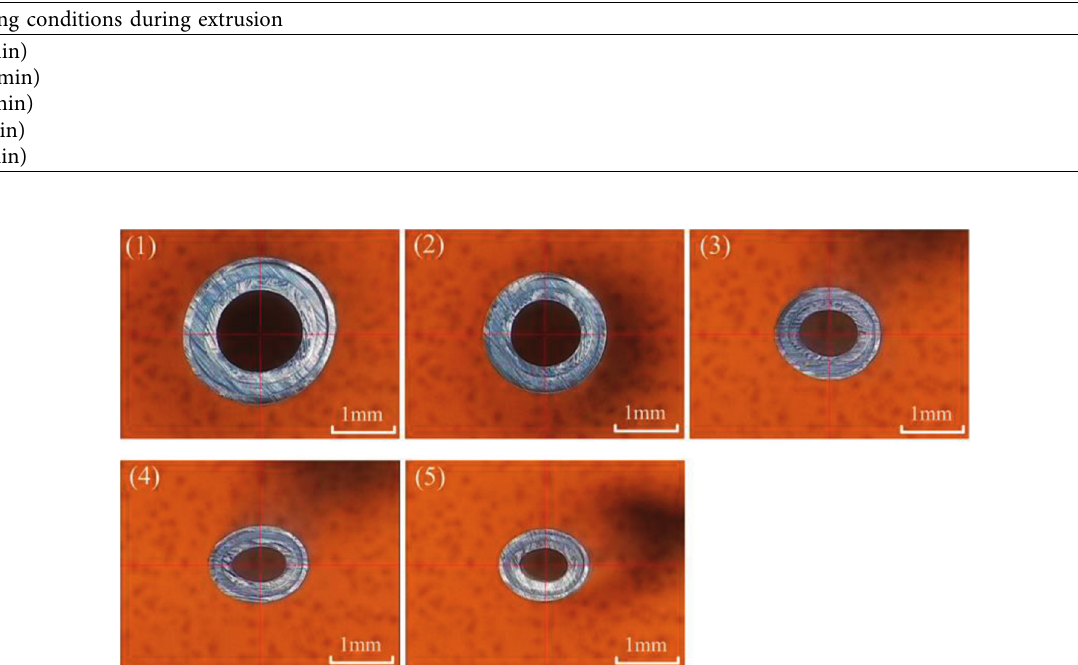
� 4m/min, (b) V � 6m/min, (c) V � 8 m/min, (d) 1 2 3